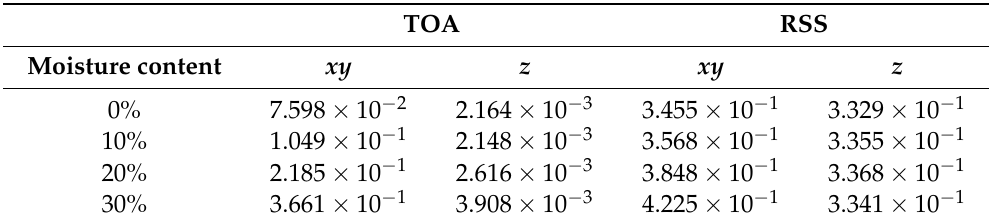
Table 3. Comparison of achieved localization